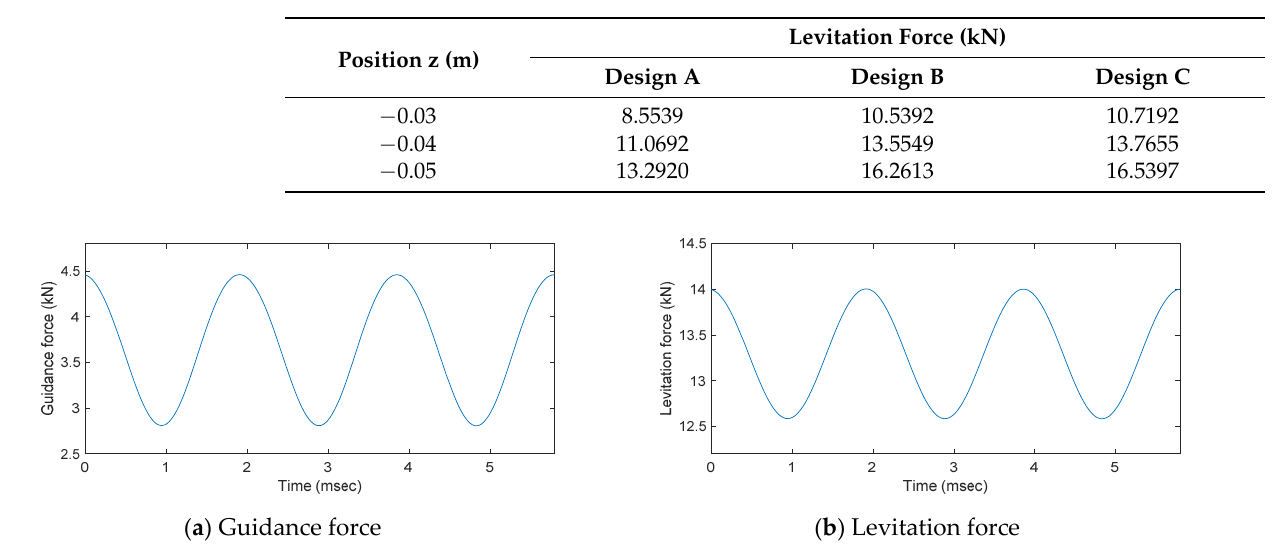
Table 2. Balance position of levitation force.